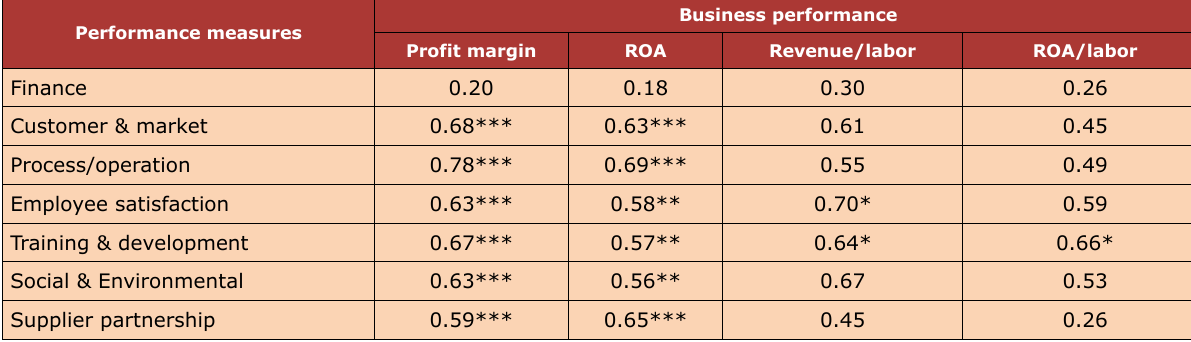
Table 9. Pearson’s correlation coefficient r. (Researchers’ computation from tables 6 &